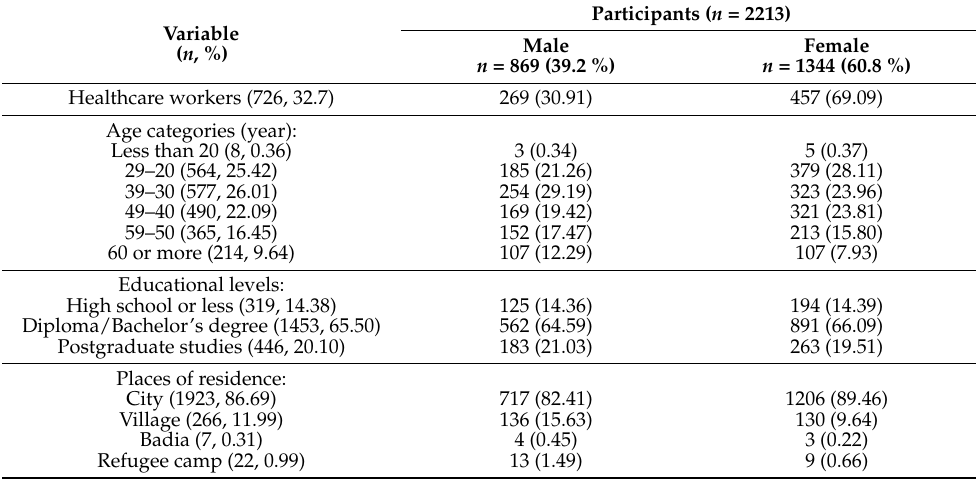
Table 1. Classification of participants involved in the study based on their demographic